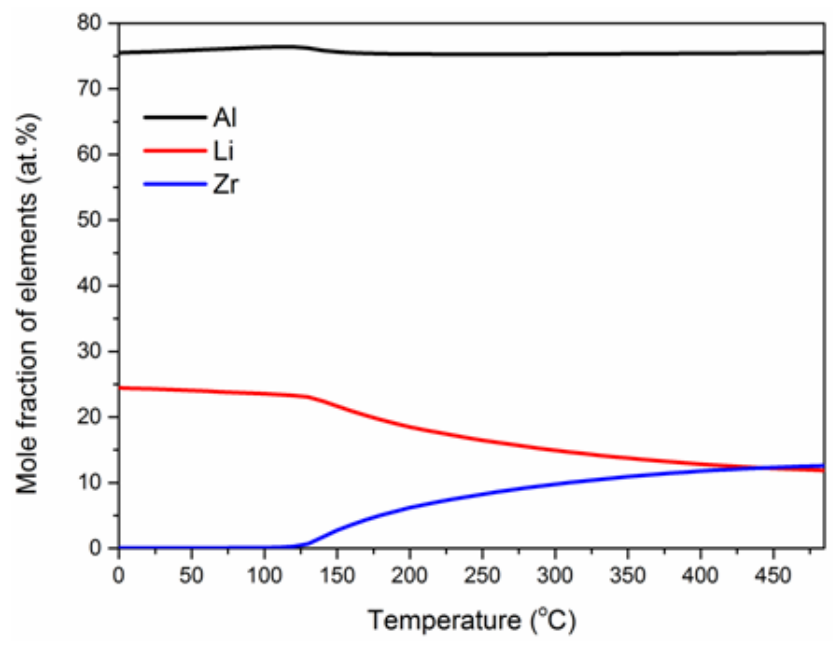
Figure 12. The content of elements in θ ’-Al2Cu phase.